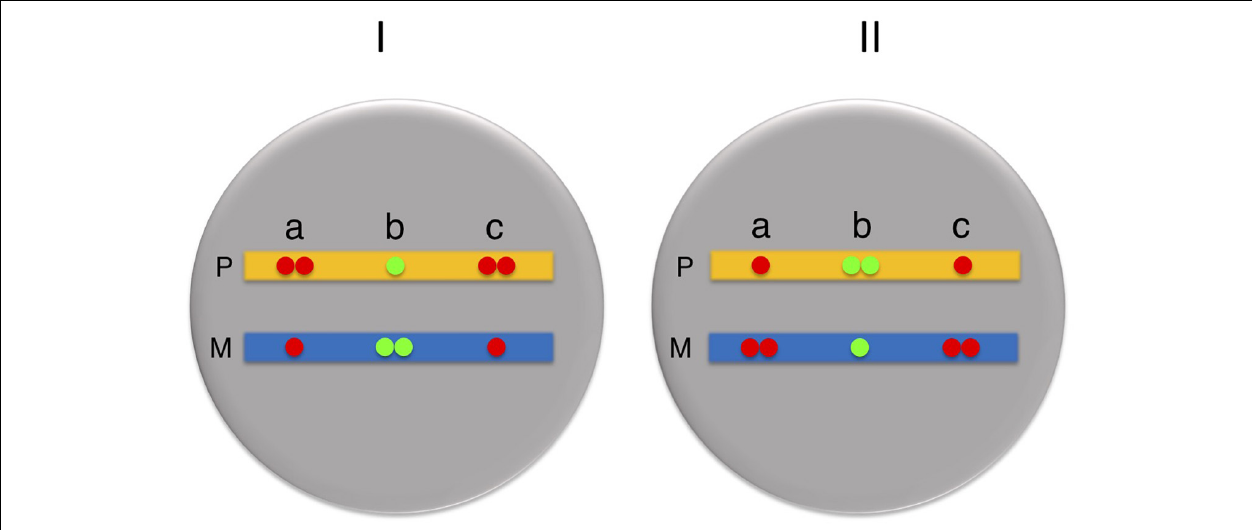
FIGURE 2 | Orientation of asynchronous regions. All cells in the body are in one of two mirror-image states (I or II) with regard to their Paternal (P, yellow) and Maternal (M, blue) alleles. Probes a and c always replicate in a parallel manner, with both being early on the same allele, while probes a and b always replicate in an antiparallel manner both in cell I and cell